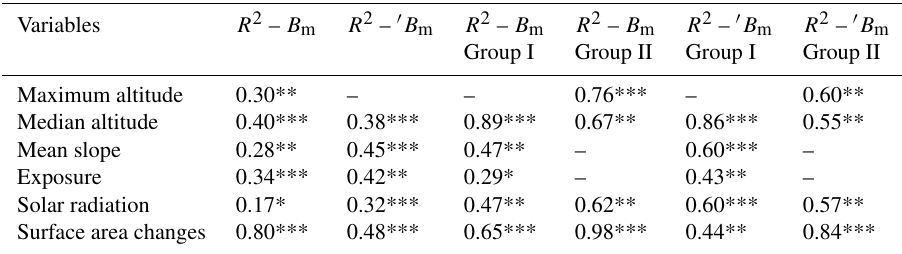
Table 5. Correlation coefficient R 2 for the regression analysis between the conventional mass balance and the morpho-topographic features and solar radiation for the period 1956–2016. Considering the mass balance B m is for all the glaciers in the ice cap, and (cid:48) B m is excluding the outlier glaciers (G1a, G5 and G16). The level of significance is indicated with p value < 0 . 01 (***), p value < 0 . 05 (**) and p value < 0 . 10